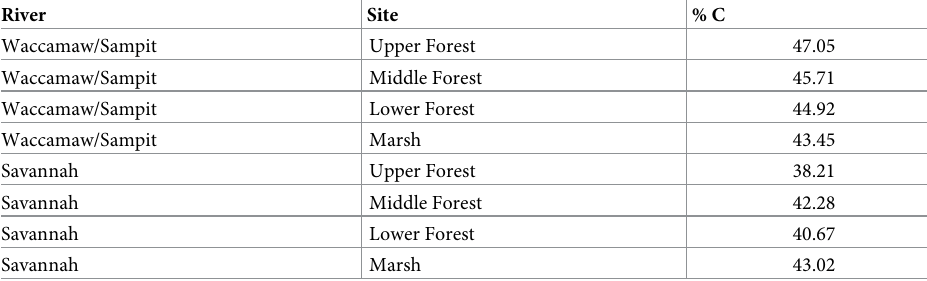
Table 1. Site-specific carbon content (%) of